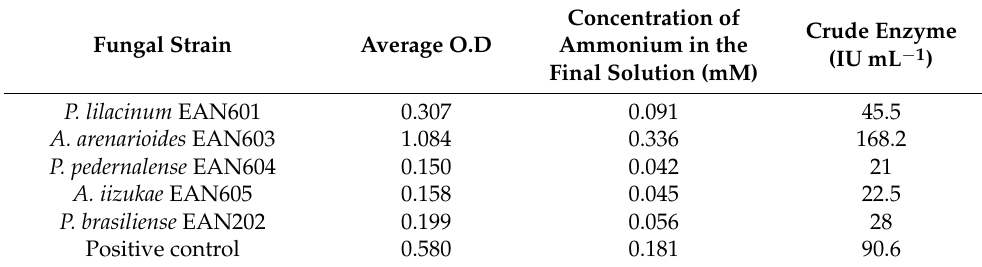
Table 2. The concentration of released ammonium in the final solution (mM) and crude enzyme (IUmL − 1 ).